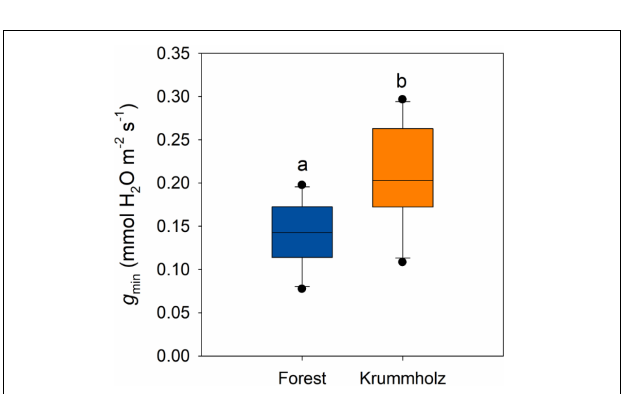
FIGURE 4 | Minimum leaf conductance ( g min ) for needles of P. uncinata grown at Forest and Krummholz populations, obtained from drying curves at 25 ◦ C. Different letters indicate statistically significant differences ( p < 0.05) between both